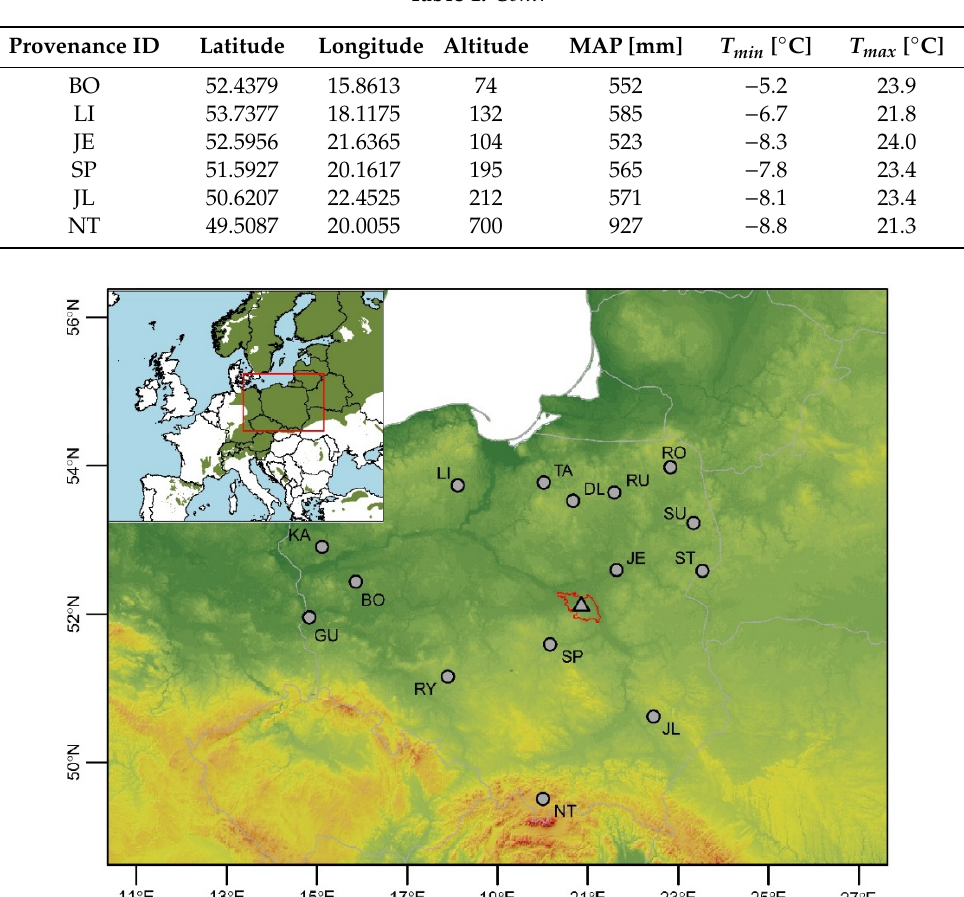
Figure 1. Location of study site. Triangle—experimental site, circles—Scots pine provenances. BO, DL, GU, JE, JL, KA, LI, NT, RO, RU, RY, SP, ST, SU and TA—Scots pine provenances. Red polygon—border of Chojnów Forest District. Top–left panel—distribution of Scots pine (Courtesy of EUFORGEN, http://www.euforgen.org/species/pinus-sylvestris/).